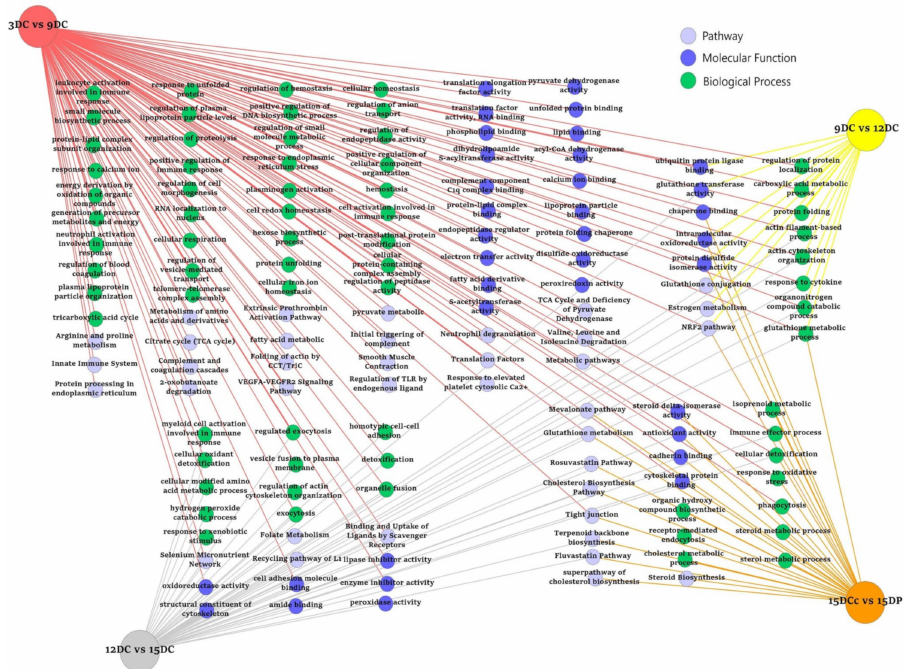
Figure 5. ToppCluster tool was used to analyze differentially abundant proteins associated with molecular function (dark blue), biological process (green), and pathways (light blue). The functional map illustrates shared and group-specific functional annotation terms generated in multicluster protein functional enrichment analysis for differentially abundant proteins identified in porcine corpus luteum in various comparisons: 3DC vs. 9DC (red circle), 9DC vs. 12DC (yellow circle), 12DC vs. 15DC (gray circle), and 15DC vs. 15DP (orange circle). The design of this network was modified in Cytoscape. The complete results are presented in a tabular format in Supplementary Table